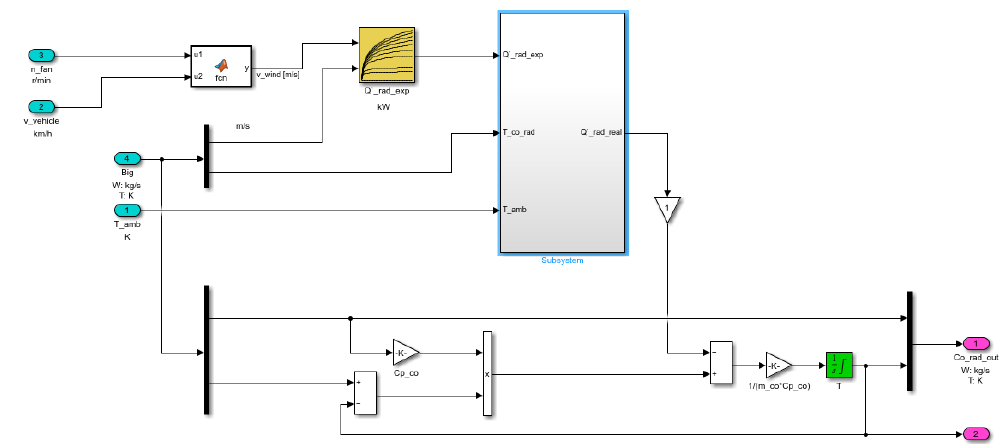
Figure 8. The Simulink model of the radiator.